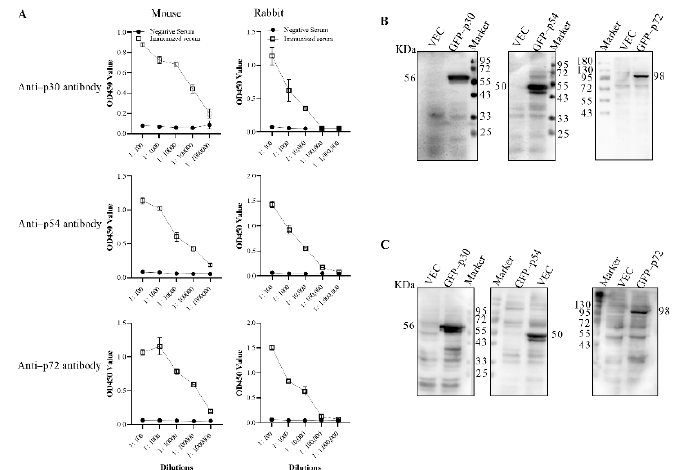
Figure 3. Confirmation of mouse and rabbit polyclonal antibodies. ( A ) The titer of the polyclonal antibodies produced in mouse and rabbit. X–axis was the sera with different dilution ratios. Y–axis on the left was OD values generated by p30, p54, p72–coated iELISA for the detection of antibody responses against p30, p54, p72, respectively. Each point on each dilution represents the mean OD values obtained from 3 mice and 3 rabbit serum samples. Results were performed as the means ± SD and analyzed with Graph–PadPrism8 software (San Diego, CA, USA). Western blot was used to confirm the specificity of the mouse ( B ) or rabbit ( C ) polyclonal antibodies. Eukaryotic expression vector containing p30, p54 and p72 genes with GFP tag or pEGFP–C1 vector were transfected into 293T cells. The cell lysates were immunoblotted with mouse or rabbit polyclonal anti–p30, p54 or p72 antibody,